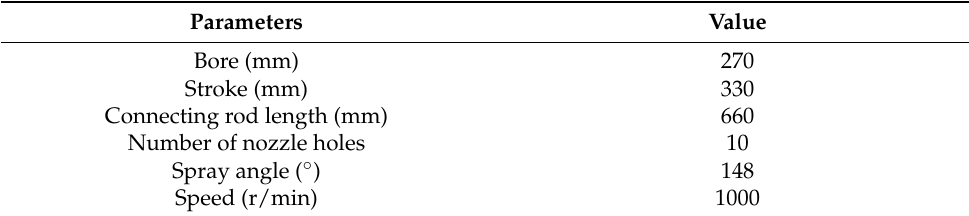
Table 1. Diesel engine specifications.